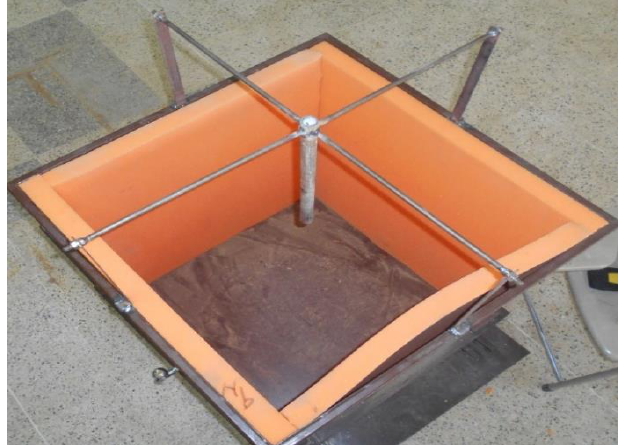
Fig. 2. Energy absorbing boundaries